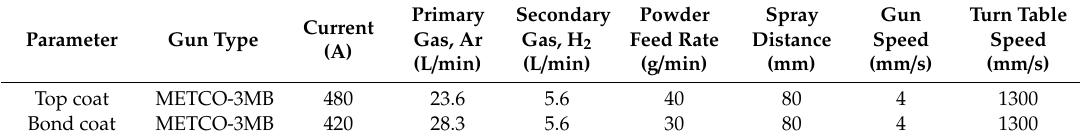
Table 1. Parameters of air plasma